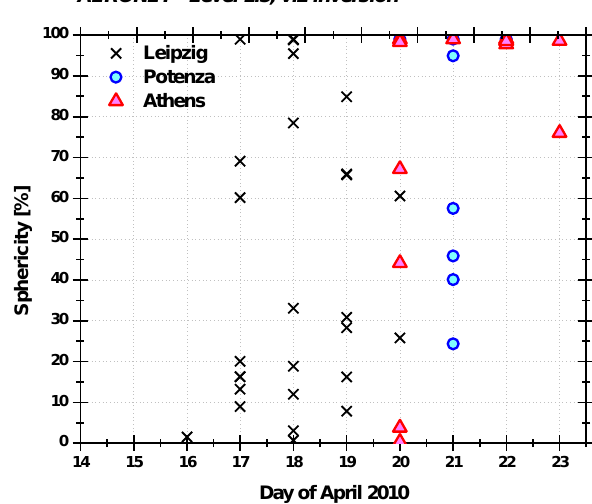
Fig. 10. Columnar aerosol sphericity values obtained from the AERONET level 1.5 standard product over Leipzig, Potenza and Athens from 16 to 23 April